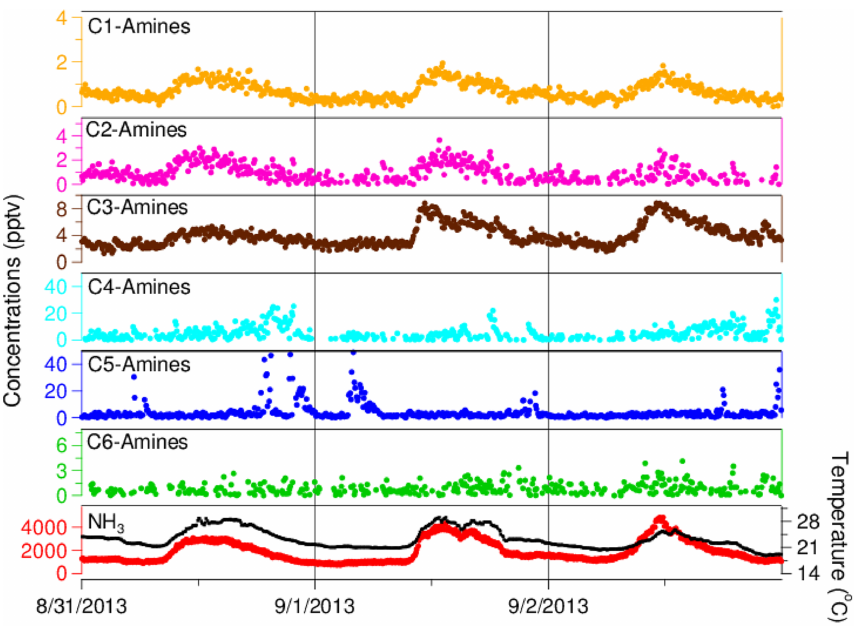
Figure 10. A typical 3-day ambient measurement of amines and NH 3 in Kent, Ohio. Ambient temperatures are also included here. Vertical bars show times at